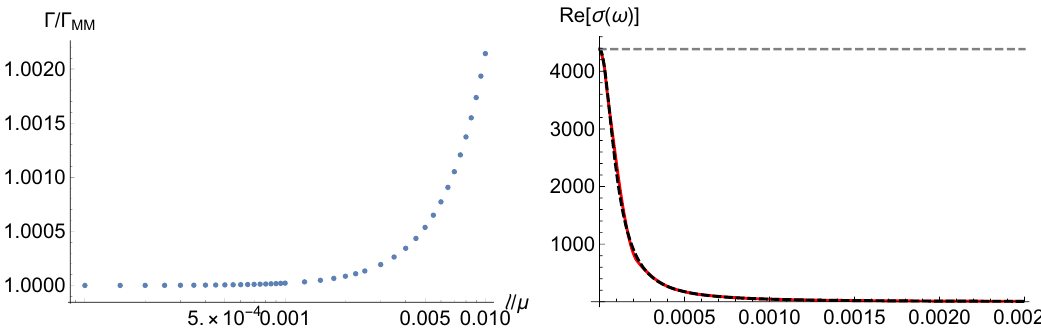
Figure 2 . In both panels, ( T=(cid:22); k=(cid:22); (cid:21)=(cid:22) ) = (0 : 1 ; 0 : 01 ; 0). Left: comparison between (cid:0) MM in (3.2) and (cid:0), the gap of the purely imaginary QNM 2 . Right: comparison at ‘=(cid:22) = 5 (cid:2) 10 (cid:0) 3 between (cid:27) hydro ( ! ) in (3.3) (dashed, black) and the numerical (cid:27) ( ! ) (red); the dashed, gray line is the dc conductivity computed from the formula